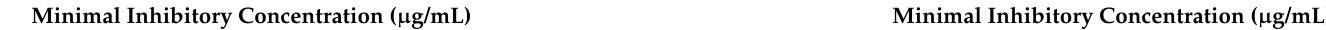
Table 2. Bacteriostatic activity of O -alkyl derivatives of naringenin and their oximes calculated as the minimal inhibitory concentration values ( µ g/mL) (according to the CLSI protocol